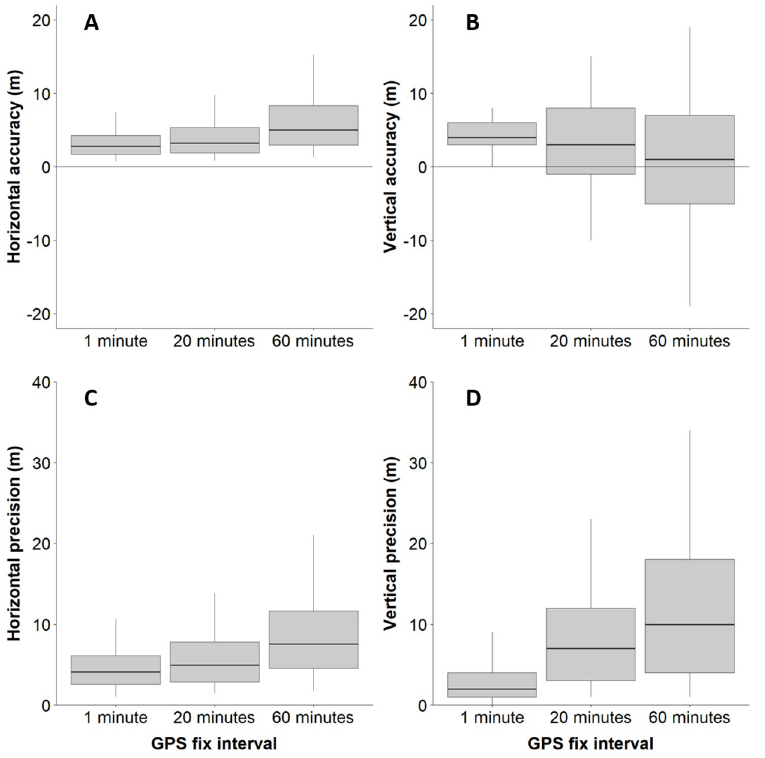
Fig 1. Horizontal and vertical accuracy and precision of devices programmed in different GPS fix intervals. Horizontal (A) and vertical (B) accuracy, and horizontal (C) and vertical (D) precision in meters of devices programmed with fix intervals of 1 minute, 20 minutes and 60 minutes. The box represents 25, 50 and 75% of the data and the error bar represents 5% and 95% of the data.